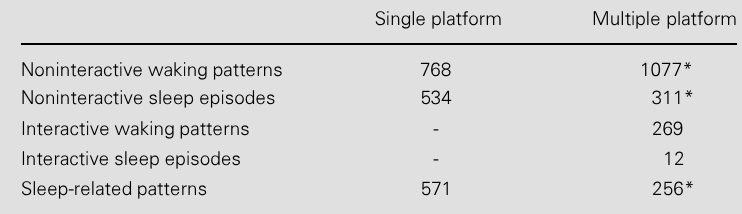
Table 1 - Total frequencies of waking and sleep behavioral patterns exhibited by rats during desynchronized sleep deprivation by the single- and multiple-platform meth-